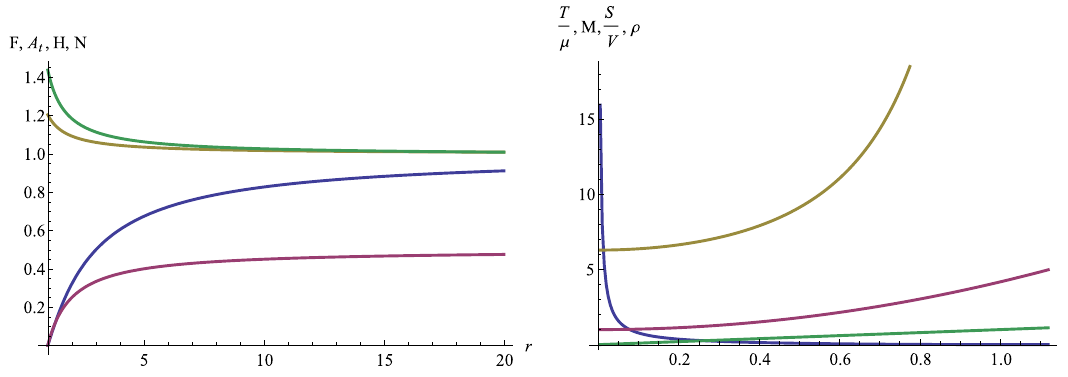
Figure 7 . Left: radial pro(cid:12)les for the (cid:12)elds F (Blue), A t (Purple), H (Yellow) and N (Green) for (cid:22) = 1. Right: termperature T (Blue), black hole mass M (Purple), black hole entropy S (Yellow) and charge density (cid:26) (Green) for the dual (cid:12)eld theory as a function of the chemical potential (cid:22)